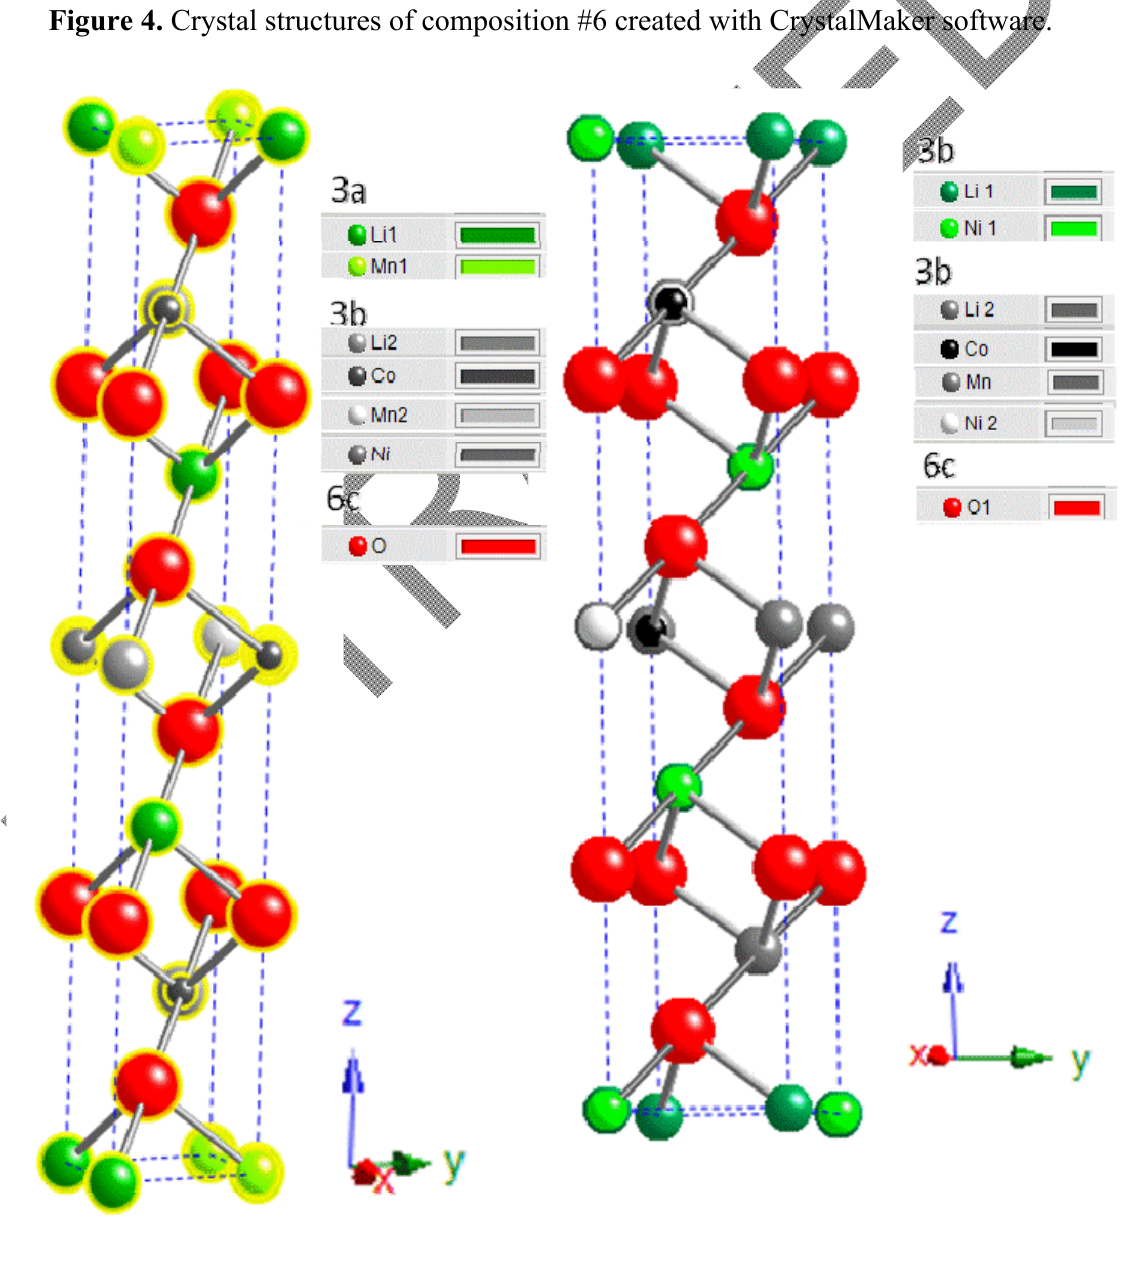
Figure 4. Crystal structures of composition #6 created with CrystalMaker